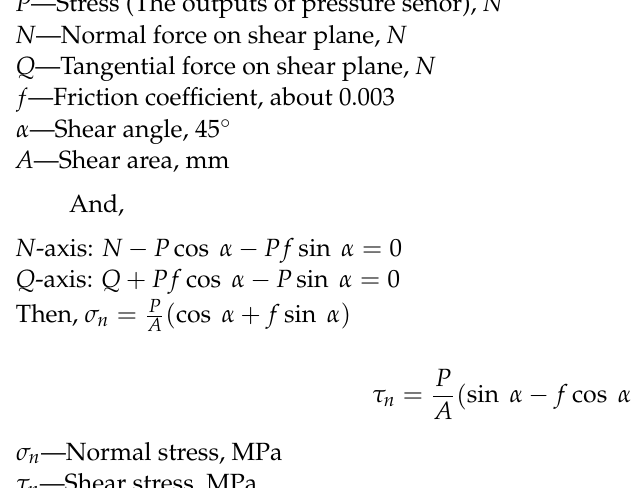
Figure 6. The stress state of the specimen under oblique shear.